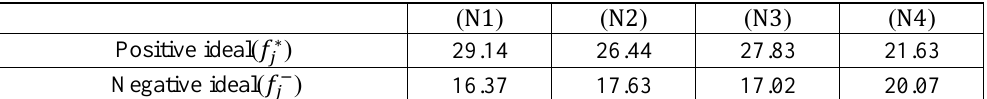
Table 11. Determining positive and negative